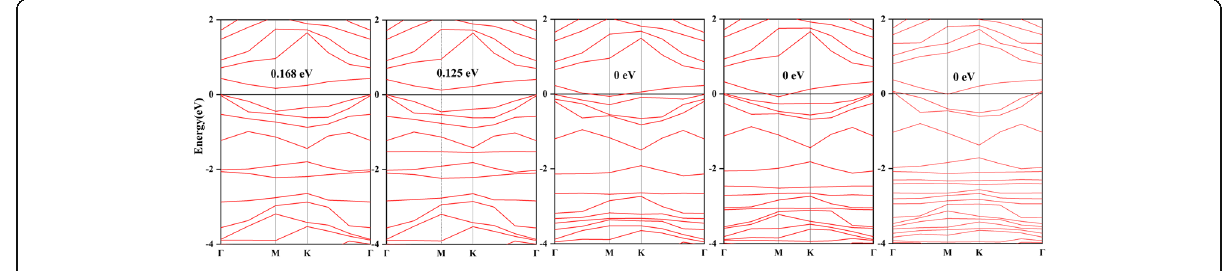
Fig. 7 Band structure of a ZnO-C 3 N monolayer, b H 2 S system, c SO 2 system, d SOF 2 system, and e SO 2 F 2